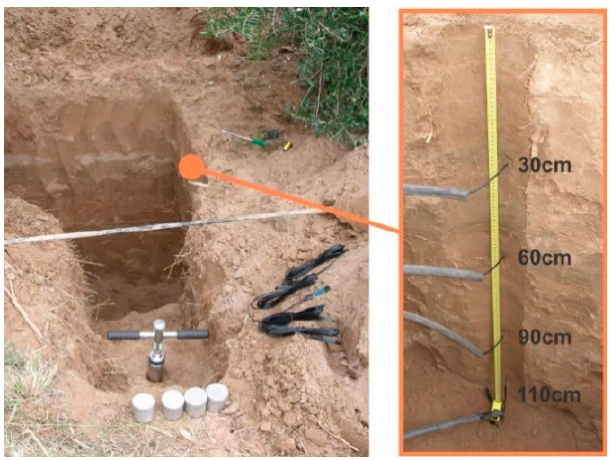
Figure 12. Soil pit performed to install four soil moisture sensors, model EC-5 from Decagon. Ten soil pits like this were made to install sensors and extract soil samples.